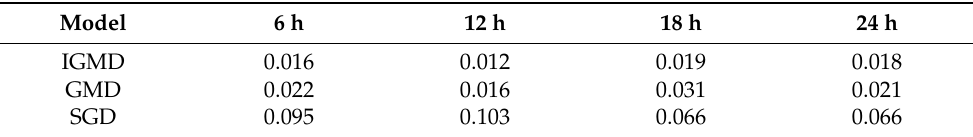
Figure 4. Histograms of the measured forecast errors and probability density curves of the IGMD, GMD, and SGD models that were used to model the forecast errors of four sub-daily lead times. Table 1. D N values for the Kolmogorov–Smirnov (K–S) test of the IGMD model at the significance level of 0.01 with the critical value of